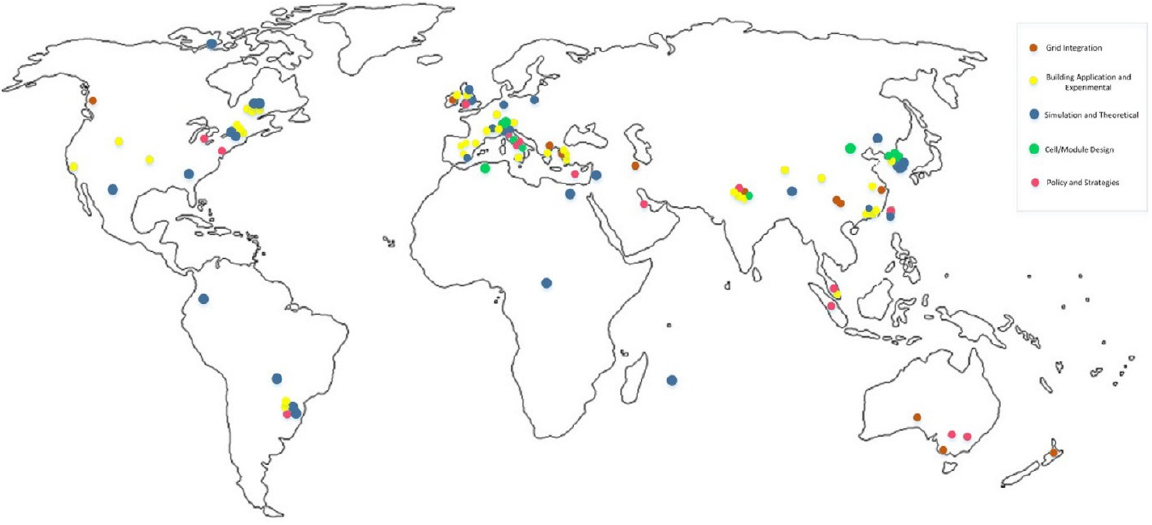
Figure 3. Studies about the BIPV indicated on the world map according to the study area [15]. Mordor Intelligence’s region-specific prediction of the BIPV market for the 2020–2025